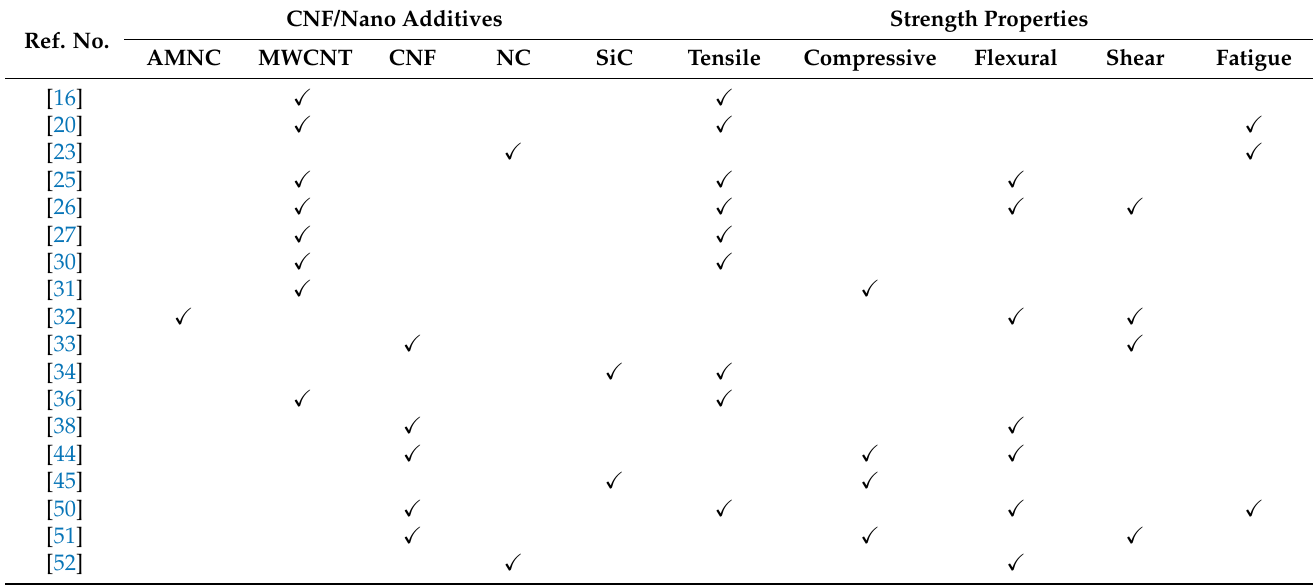
Table 1. Nano additives and their influence on improving the mechanical properties.